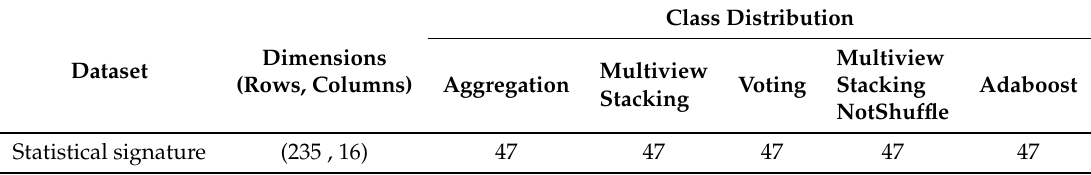
Table 12. Balanced Statistical signature data set.